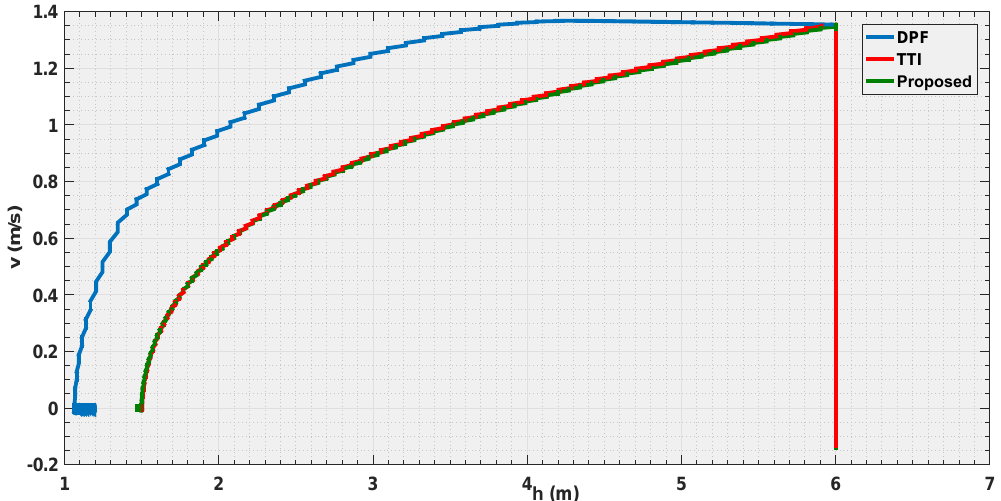
Figure 17. Reference velocity with respect to the distance for the three evaluated algorithms Experiment 2 .